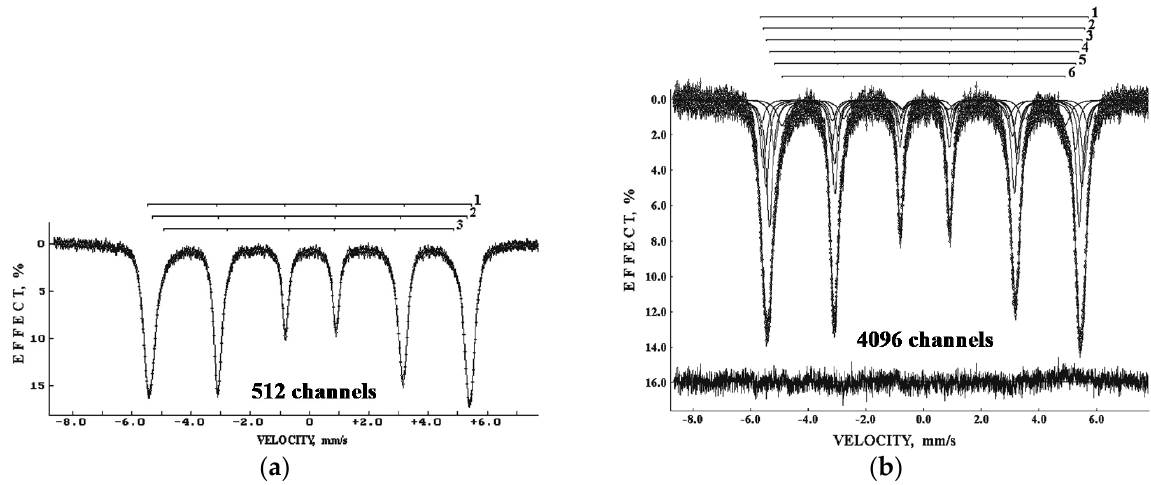
Figure 27. Room temperature Mössbauer spectra of Chinga iron-ung meteorite: the spectrum presented in 512 channels ( a ) and the spectrum presented in 4096 channels ( b ). Indicated components are the results of the best fits. The differential spectrum is shown on the bottom in ( b ). Adapted from [76].